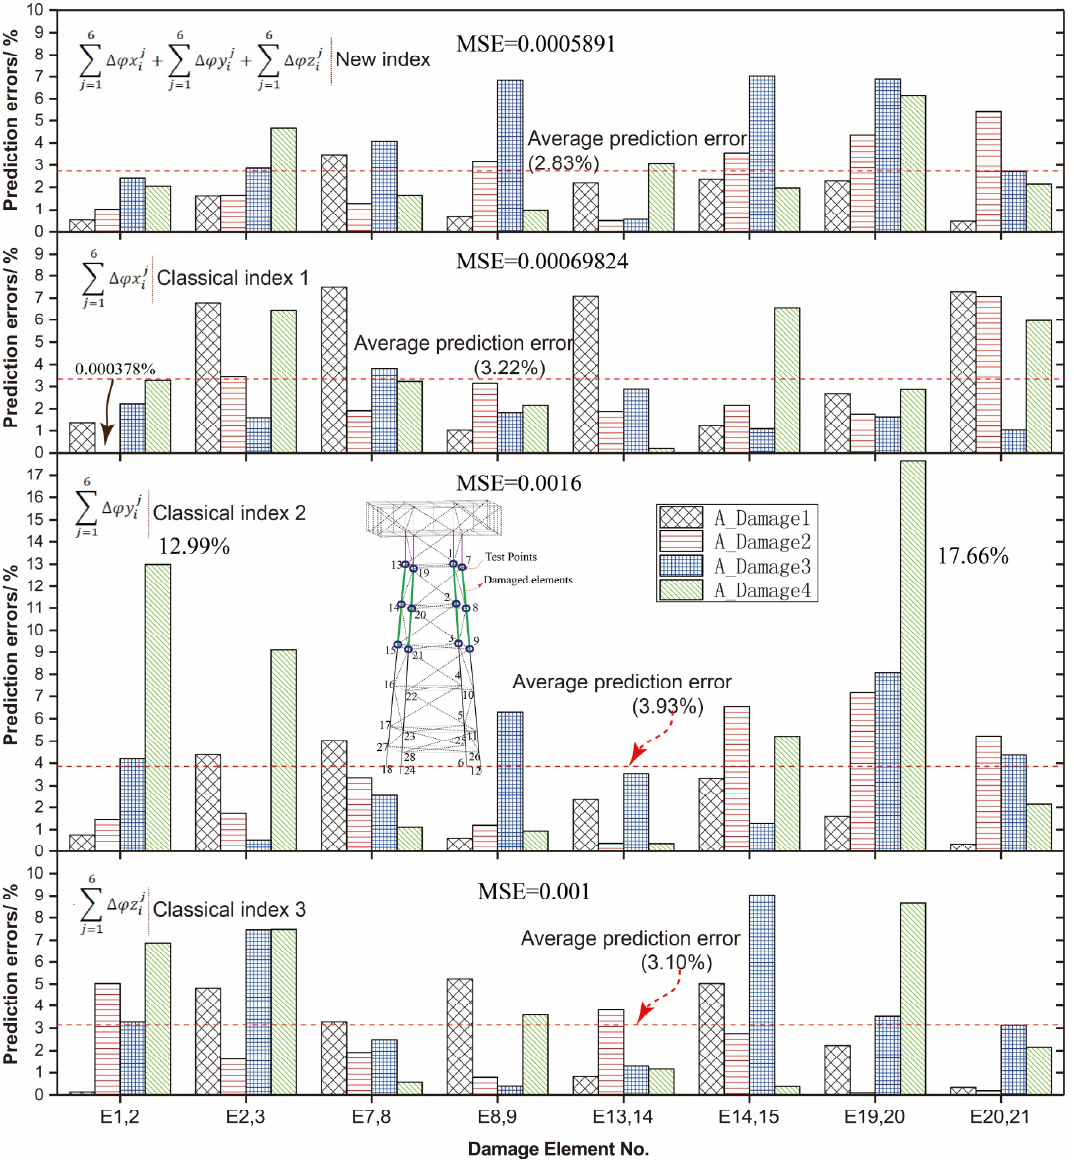
Figure 7. Comparison of the prediction accuracy of the new damage index against classical indices for area